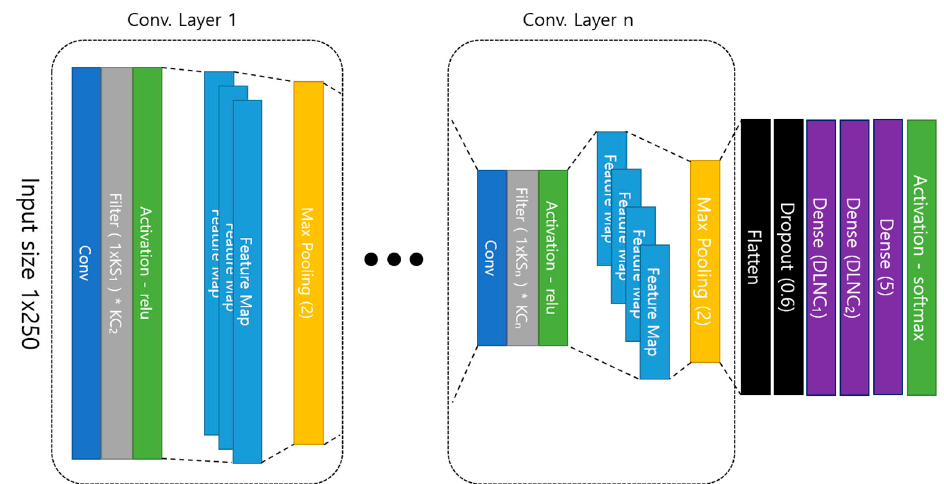
Figure 6. Proposed 1D Convolutional Neural Network structure.